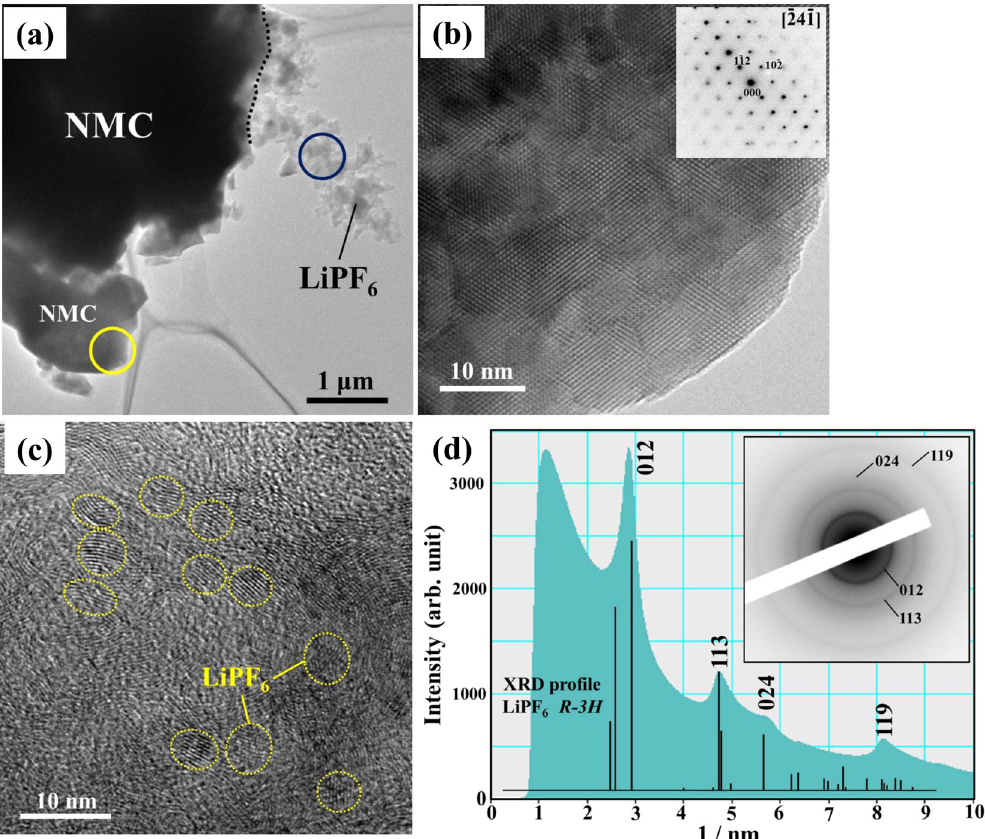
Figure 6. ( a ) The BF image showing the morphology of the charged NMC composite with the 1 M LiPF 6 -EC/ EMC solution, which was heated at 240 °C. ( b ) The HR image taken from the NMC region indicated by the yellow circle in ( a ). ( c ) The HR image taken from the LiPF 6 region indicated by the blue circle in ( a ). ( d ) The ED pattern obtained from the LiPF 6 region and the corresponding intensity